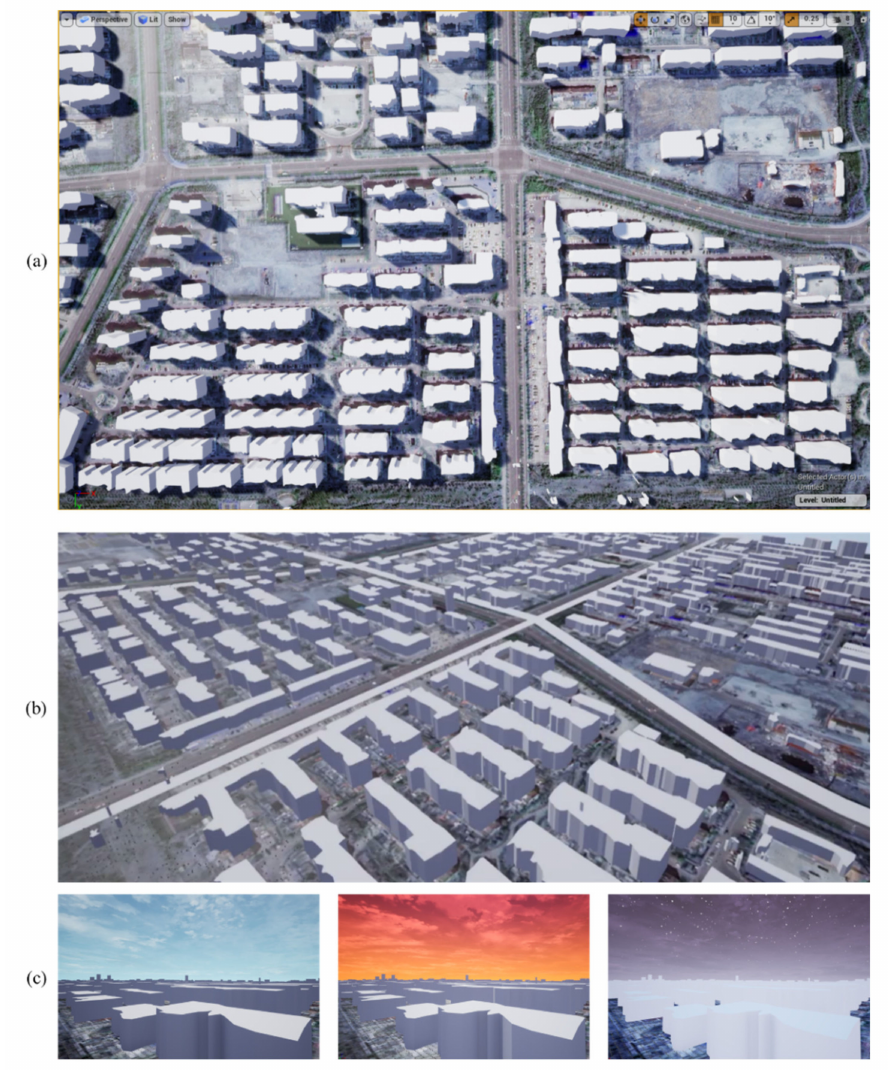
Figure 14. Effects of the urban scene level in UE4. ( a ) Ortho-angle of part of the scene; ( b ) side view of the scene; ( c ) different environmental effects in the scene, including daytime, dusk, and